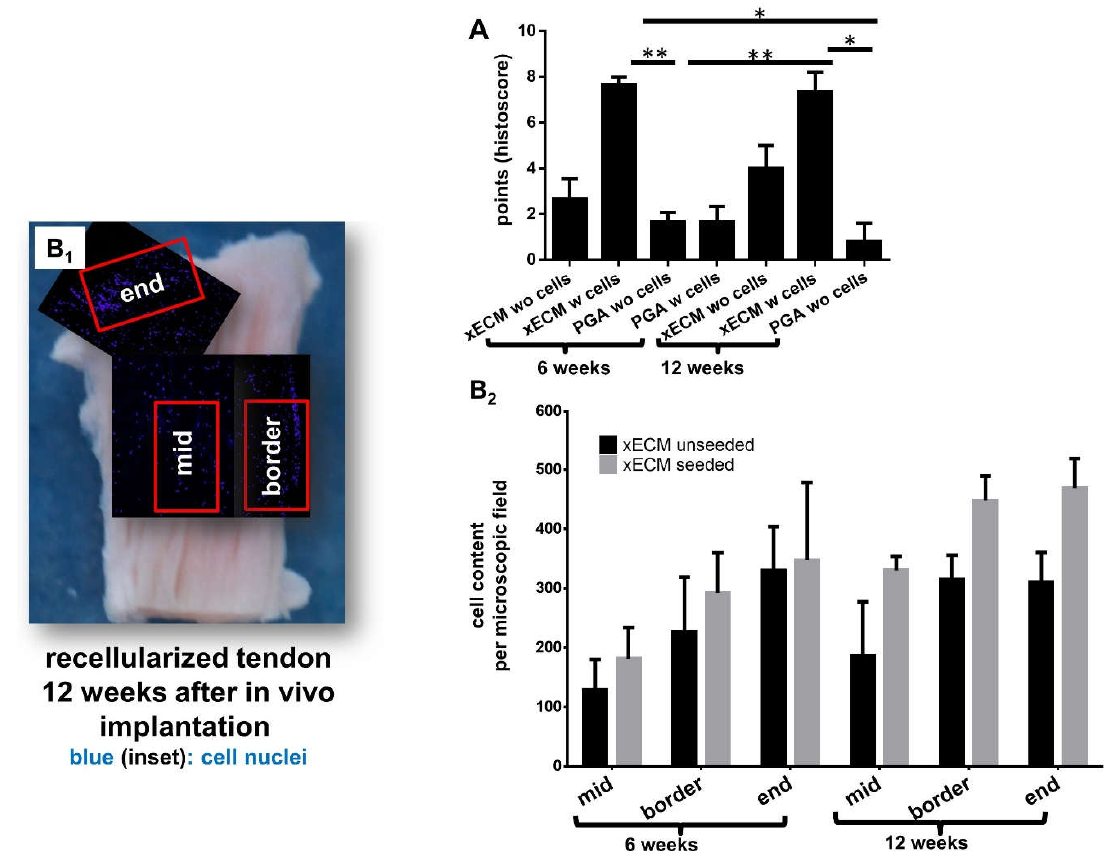
Figure 5. Results of histopathological scoring and cell numbers of decellularized xECM or PGA seeded or not with human tenocytes six and 12 weeks after in vivo incubation. ( A ) Results of histological scoring, ( B 1 ) areas included in cell number calculations and ( B 2 ) counted cells based on DAPI staining. DAPI-stained cell nuclei were counted in an equal-sized tissue area of a cryo-section. n = 3. PGA: polyglycolic acid. wo: without cells, w: with cells. * p < 0.05, ** p < 0.01.